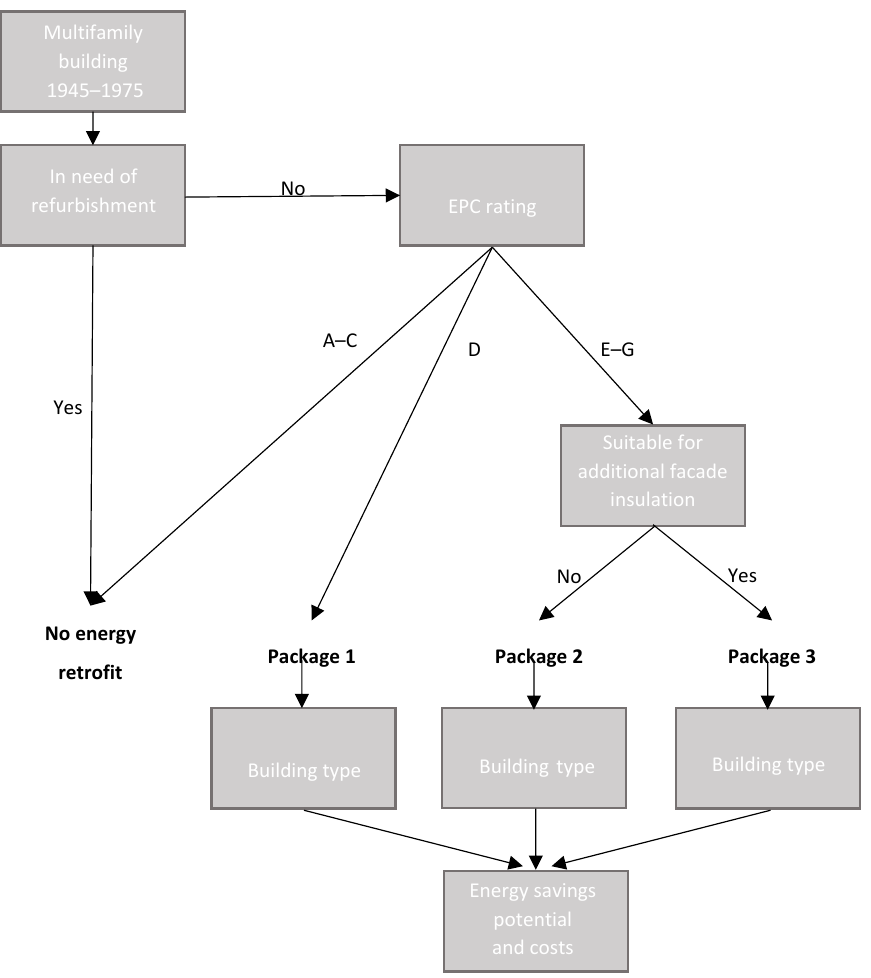
Figure 7. Decision tree showing how four building characteristics (renovation status, EPC rating, suitability for additional façade insulation, and building type) can help determine a tailored energy retrofitting package for each individual building based on the suggested energy retrofitting packages described in Section 2.3.